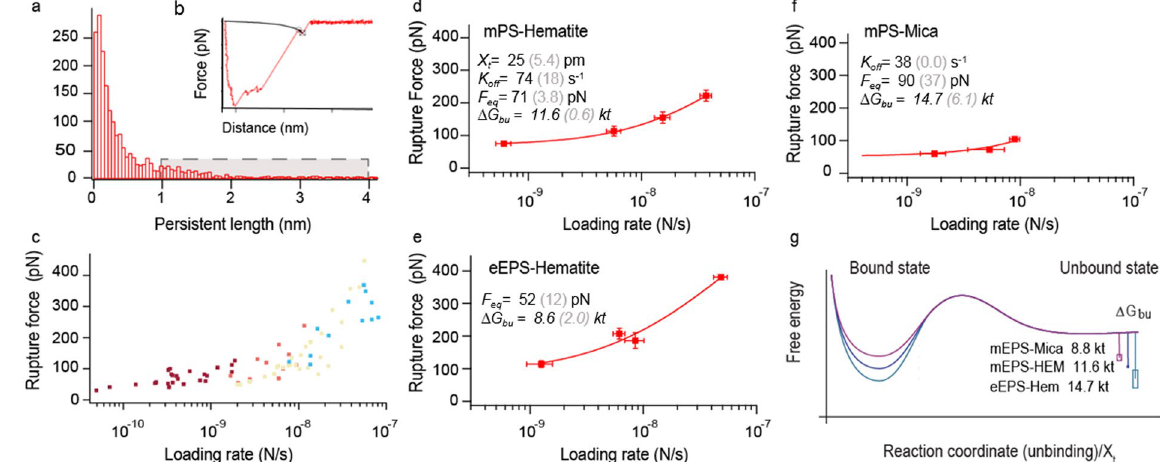
Figure 2. Analyzing polymer-based DFS data. ( a ) Histogram of l p showing the block of filtered values in grey. ( b ) WLC fit to a force curve. ( c ) Data in Fig. 1a filtered for persistence lengths. Color coding show the velocity groups used for obtaining the mean r and l r . (Fig. 2d). ( d – f ) f r vs r for the EPS-mineral interactions. ( g ) Free energy